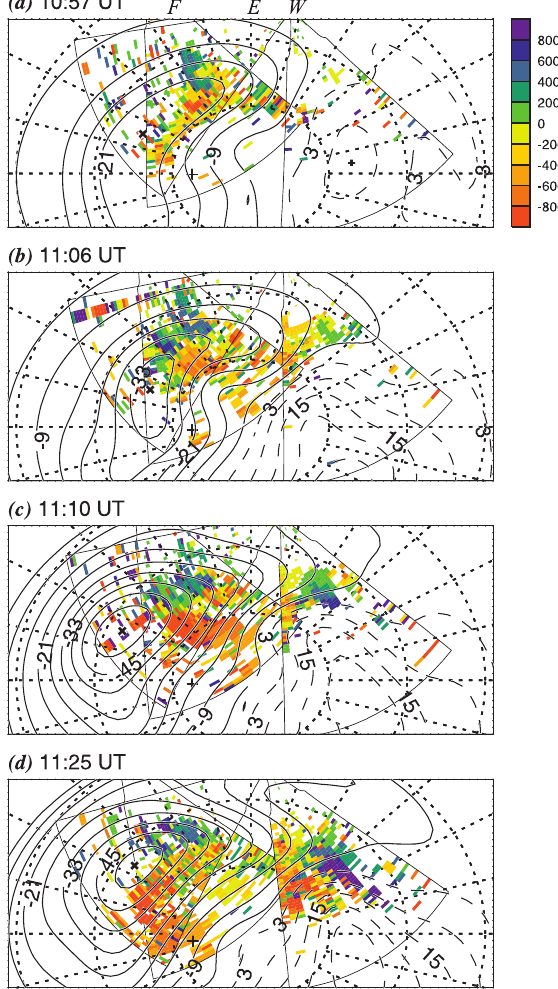
Fig. 4. The map potential contours derived from the Doppler veloc- ities measured in the dayside auroral zone by the Þykkvibær ( E ), Hankasalmi ( F ), and Stokkseyri ( W ) SuperDARN radars. Equipo- tential contours have been determined by fitting a series of spher- ical harmonic functions to the measured convection velocity com- ponents measured by the SuperDARN radars and constraining the fits with statistical convection models based on upstream IMF con- ditions. Following the southward turning of the IMF, the extent of the measurements in the dayside auroral zone by the SuperDARN radars steadily